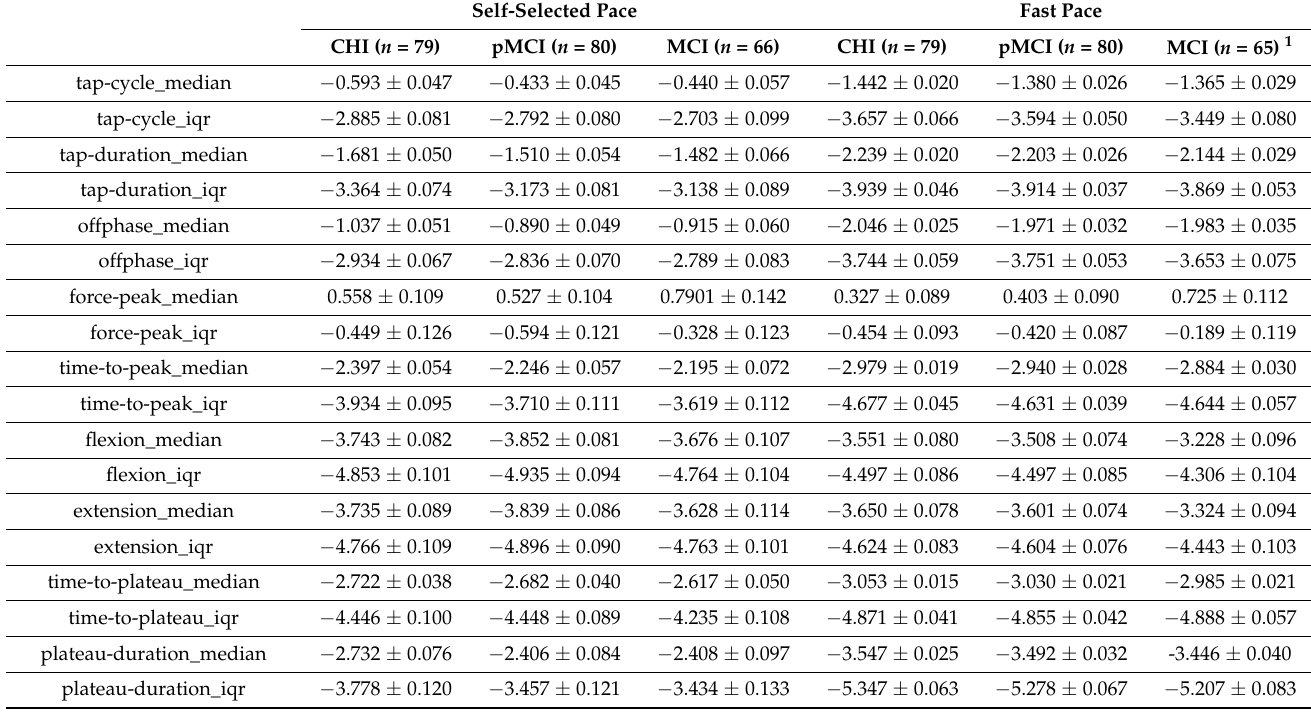
Table 2. Logarithmized tapping parameters for both conditions for each group. Self-Selected Pace